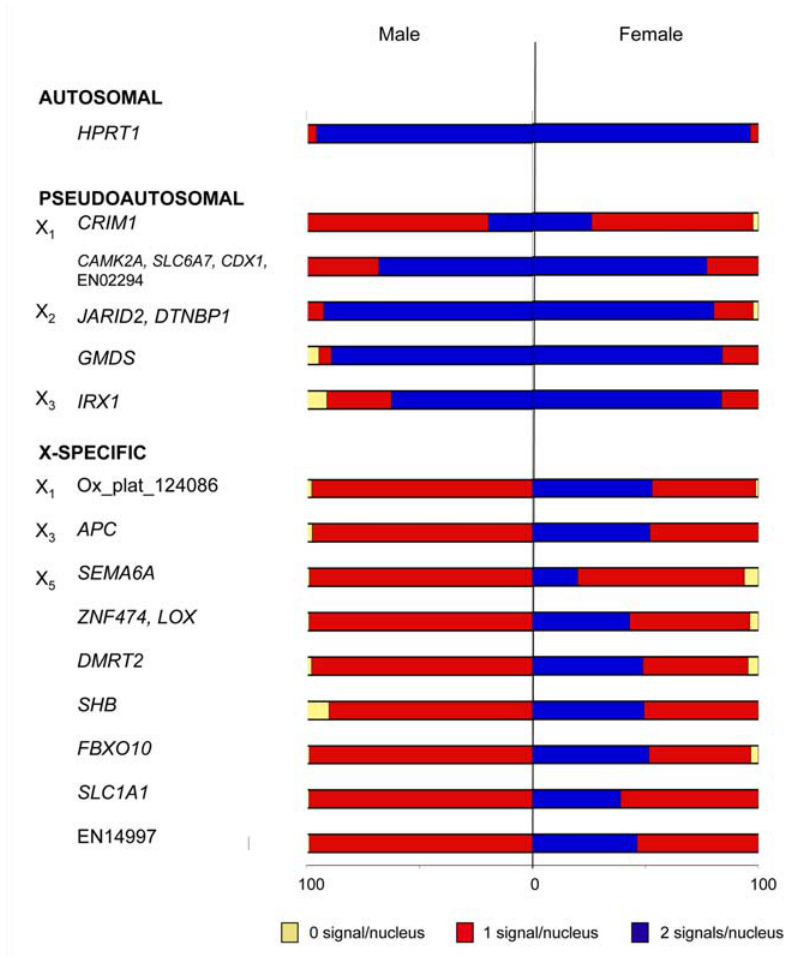
Figure 2. Summary of RNA-FISH results in platypus cells. Frequency of cells in which transcription of no (yellow), one (red) or two (blue) alleles is detected by RNA-FISH in male and female interphase nuclei. Autosomal control, pseudoautosomal and X-specific genes are grouped, with a distinct difference observed between the X-specific genes and the autosomal and pseudoautosomal genes.